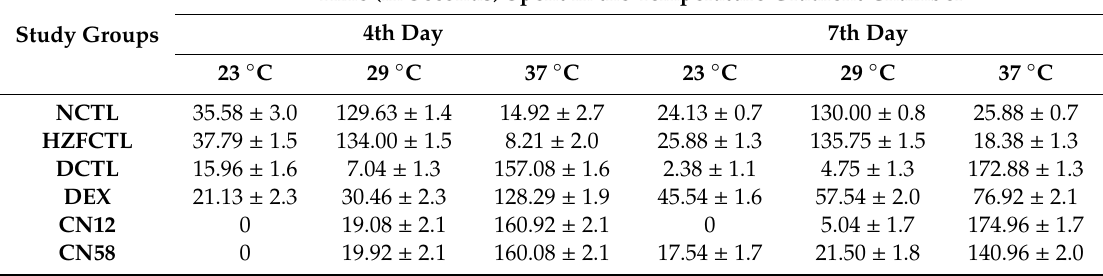
Table 2. Time (in seconds) spent by experimental fish of each test group in various temperature chambers. Data are expressed as mean ± S.D. values ( n = 24 for each